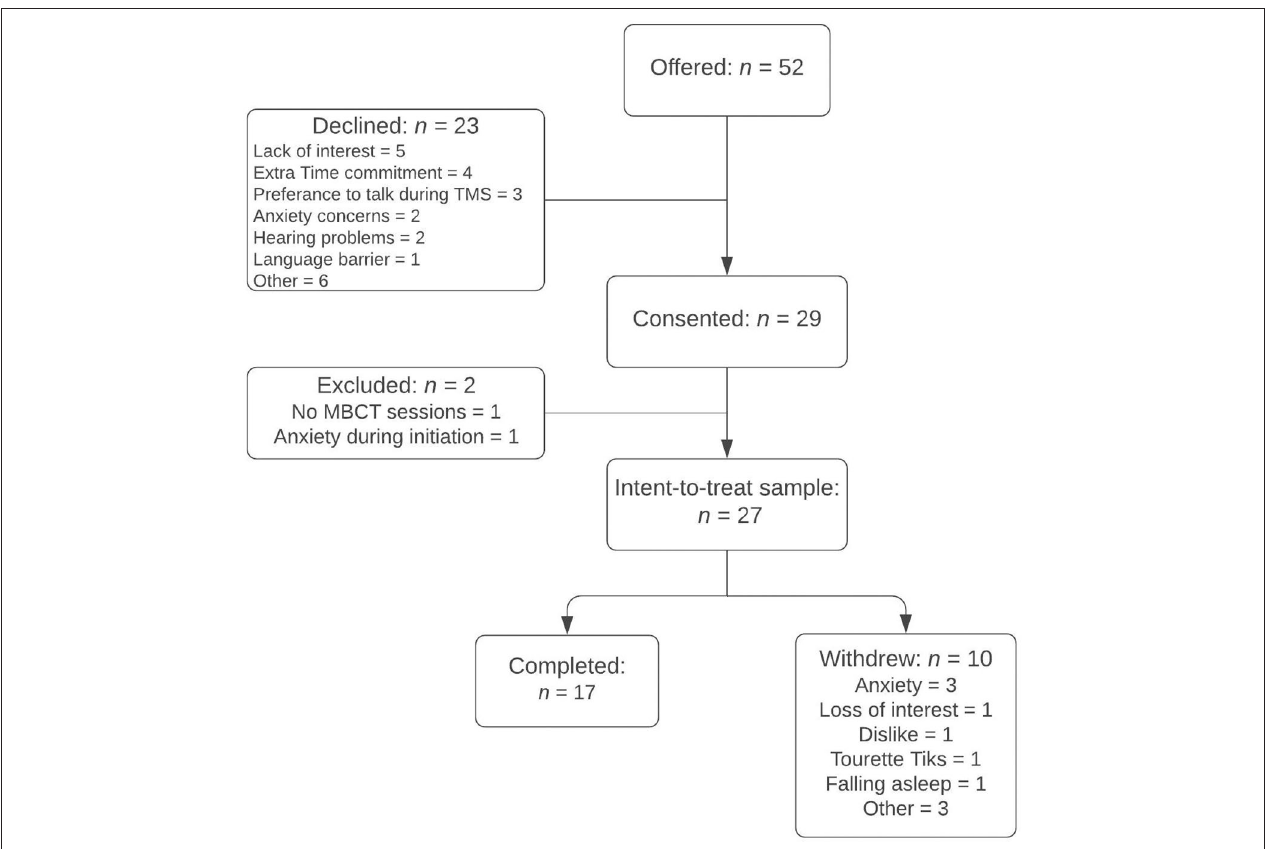
FIGURE 1 | Participant Flowchart. MBCT = Mindfulness-Based Cognitive